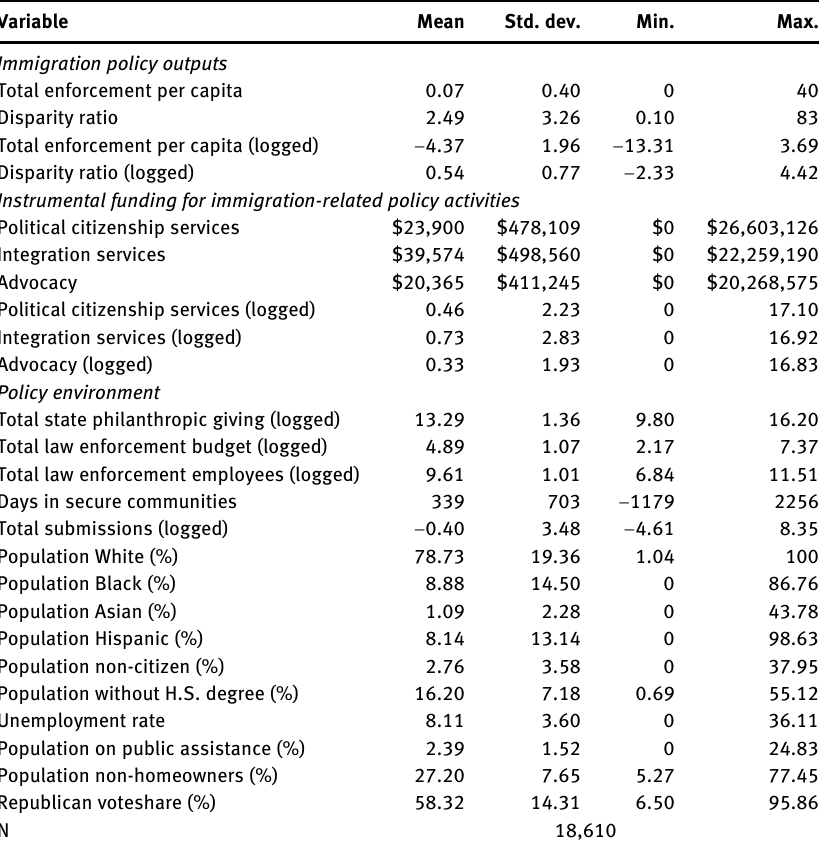
Table  : Summary statistics.